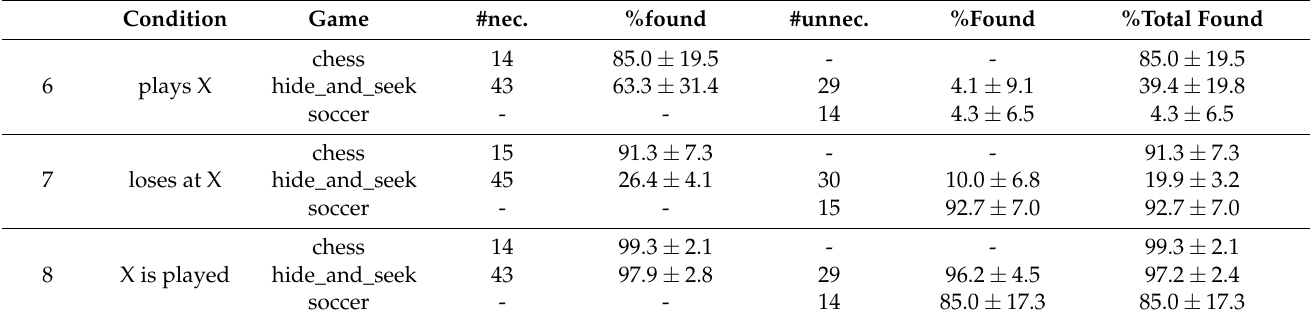
Table 9. Results of Conditions